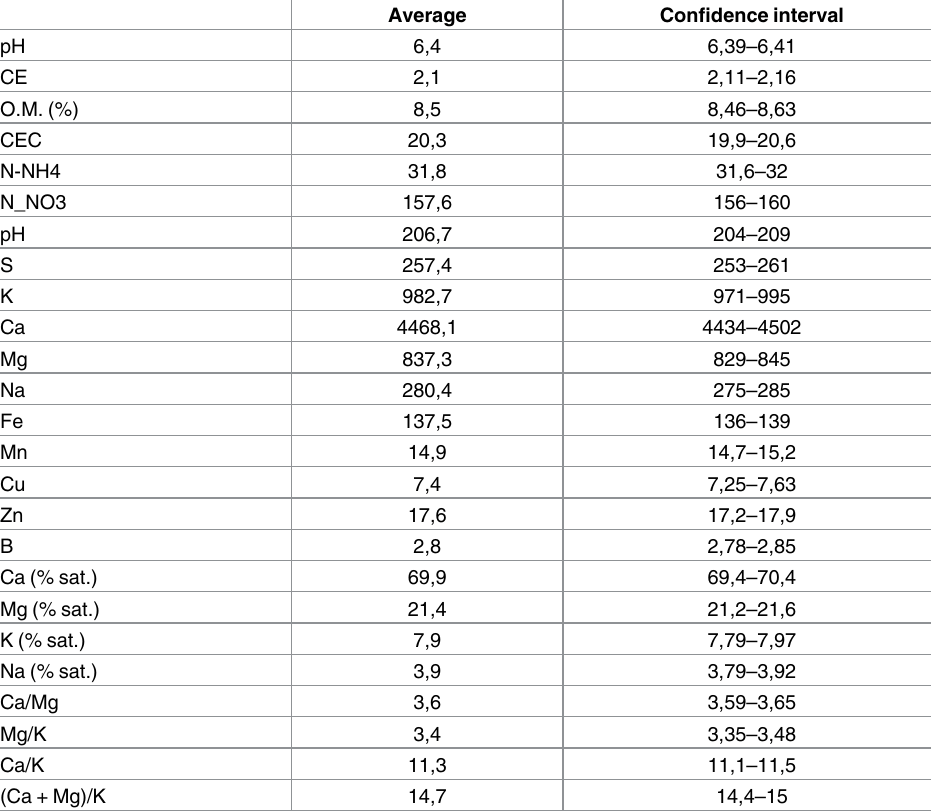
Table 1. Average values and confidence interval (n = 9555 and p (cid:20) 0,05) of the chemical characteris- tics of soils dedicated to floriculture on the Bogota´ Plateau, Colombia. Values obtainedfrom the data- base of the G.R. Chia SA Soil